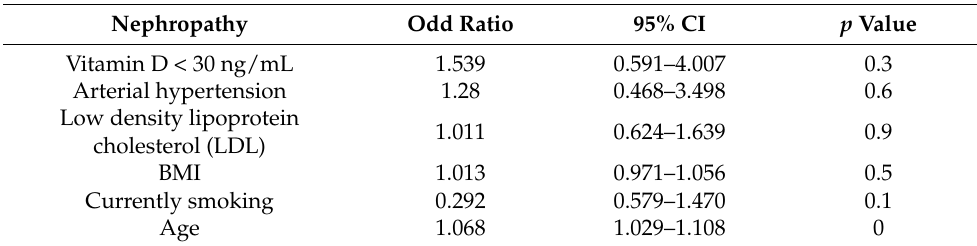
Table 3. Logistic regression investigating diabetic nephropathy for the threshold of vitamin D, vitamin D < 30 ng/mL, and five confounders. BMI, body mass